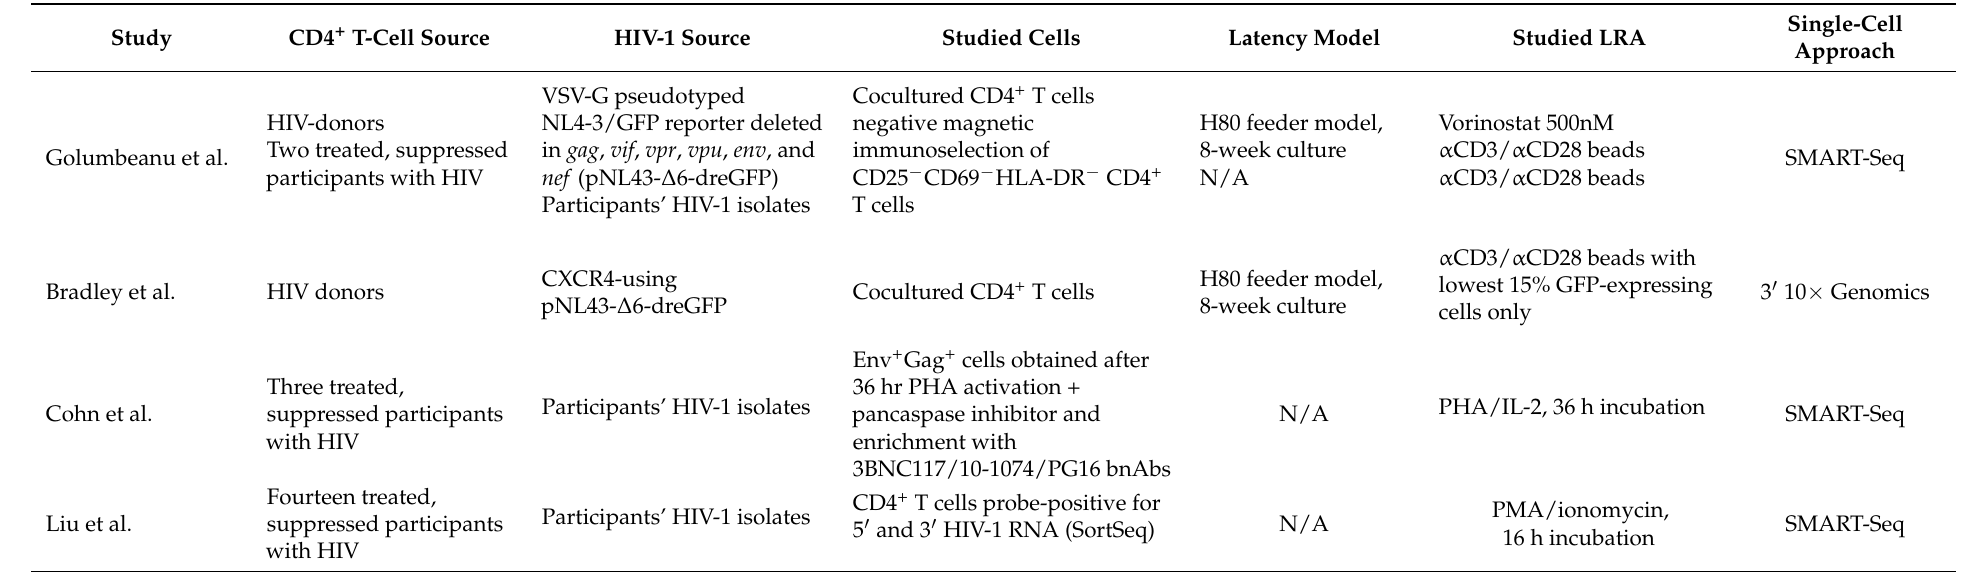
Table 1. Published single cell studies of HIV-1 latency